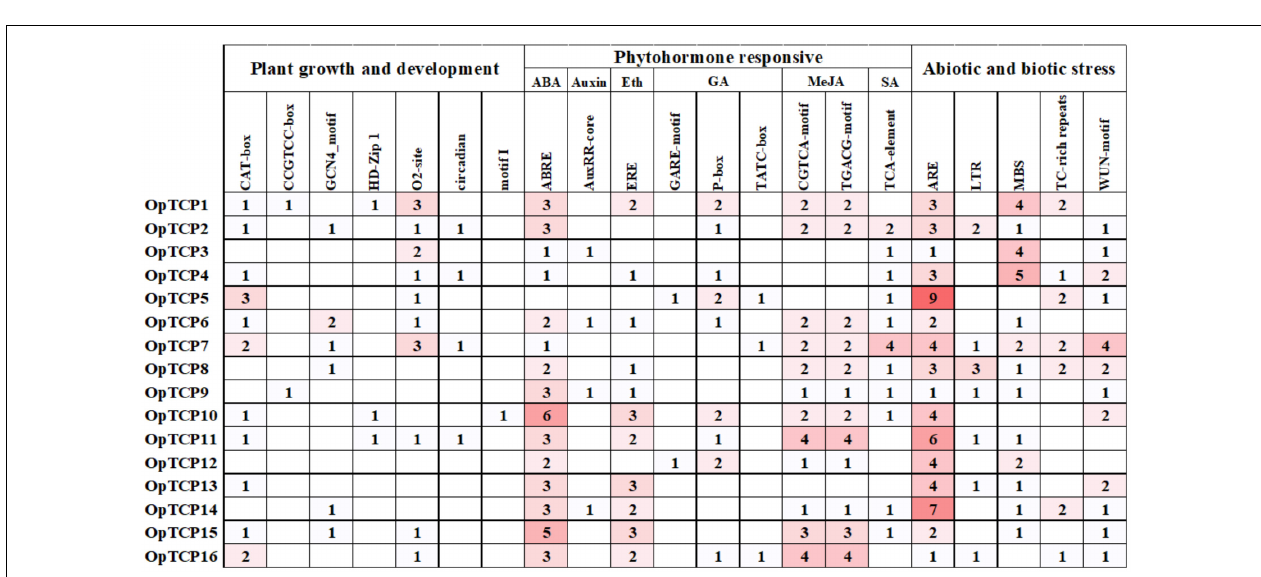
FIGURE 3 | Phylogenetic analysis, gene structure, and conserved motifs of TCP family in O. pumila . (A) The conserved TCP domain sequences of OpTCP proteins were constructed a Neighbor-Joining phylogenetic tree and the bootstrap test was performed with 1,000 iterations. (B) Exon-intron structure of the OpTCP genes. Blue indicates untranslated 5 (cid:48) - and 3 (cid:48) -regions, yellow indicates exons; black indicates introns; 0, 1, 2 indicates intron phase. (C) Distribution of conserved motifs of OpTCP proteins. Different motifs are shown by different colors numbered 1–10. TCP, teosinte branched 1/cycloidea/proliferating cell factors 1/2; OpTCP, O. pumila TCP.